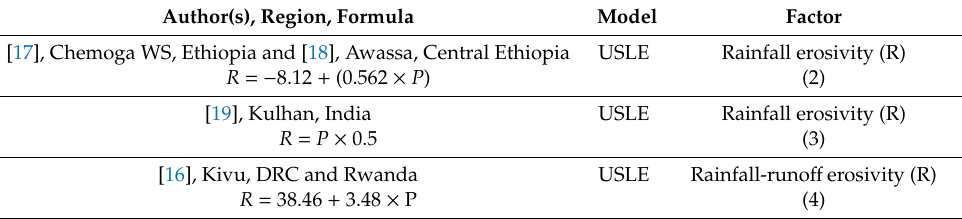
Table A1. Overview of R factor calculations of selected